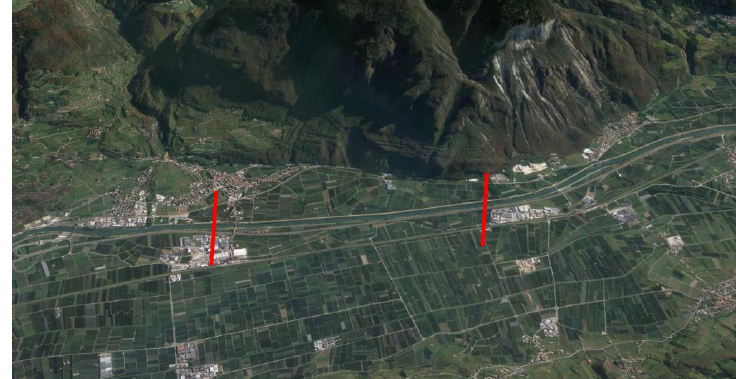
Figure 1. A22 (103 + 500 Km − 107 Km) northern direction (adapted from Google Earth).